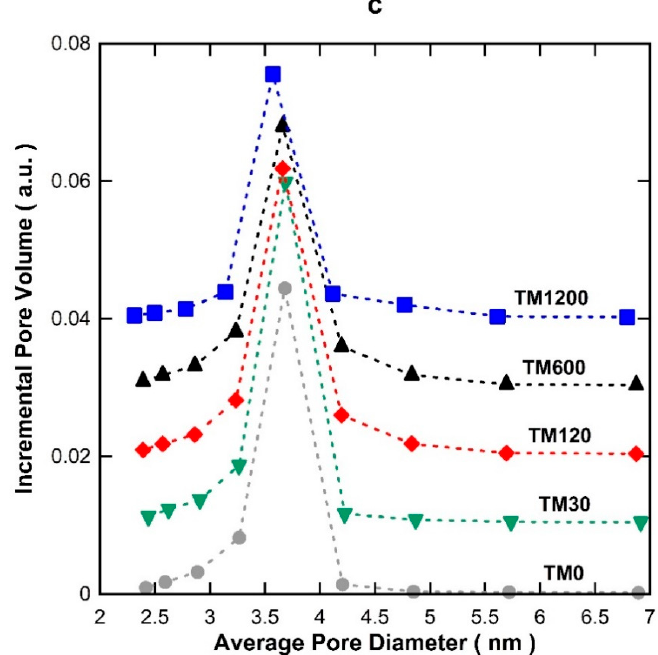
Figure 1. ( a ) Nitrogen adsorption isotherms (full symbols for adsorption and hollow symbols for desorption); ( b ) Brunner-Emmett-Teller (BET) surface area and pore volumes; and ( c ) pore size distribution of titania membranes (TM) xerogels exposed to varying vacuum times.